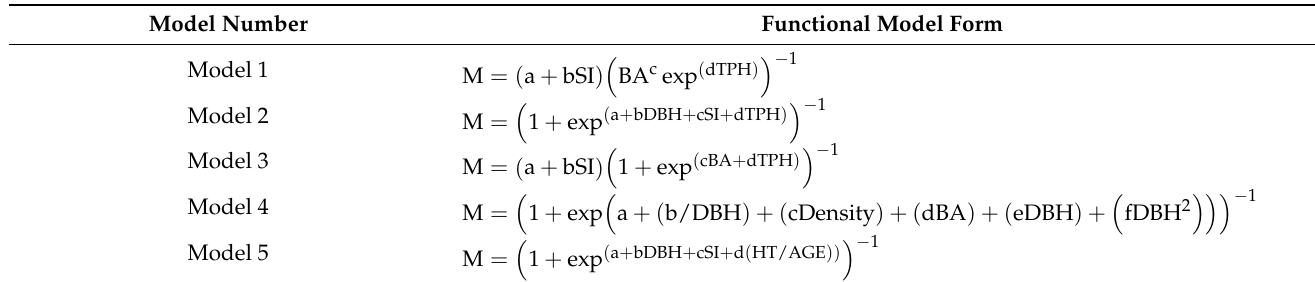
Table 3. Mortality model forms used in this